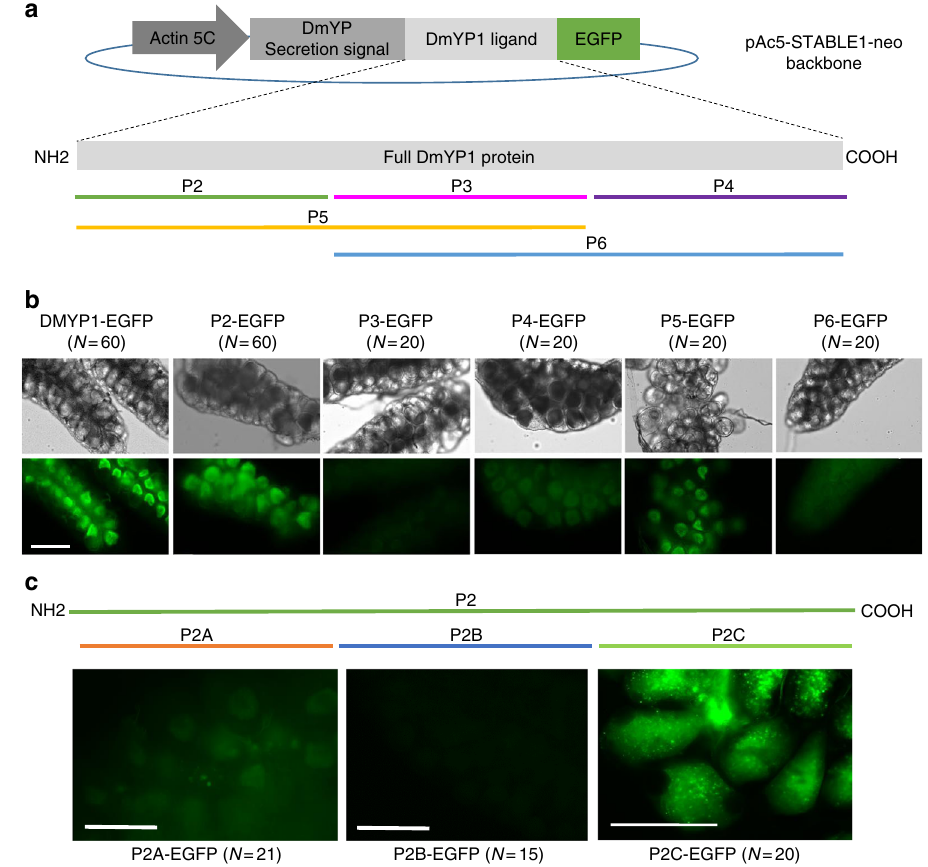
Fig. 1 Deletion mapping of D. melanogaster DmYP1 and P2C-mediated delivery of EGFP. a Schematic showing the construct pAc5-STABLE1-neo backbone modi fi ed to express and secrete EGFP fused to DmYP1 or any of its derivatives (P2, P3 – P4, P5, or P6) under the Actin5C promoter in S2 cells. Fragments P2, P3, and P4 are about 120 amino acids of DmYP1 each. Portion P5 contains portions P2 and P3. Portion P6 contains P3 and P4. b EGFP fusion proteins containing DmYP1 or each fragment (P2 – P6) as ligand were injected into the hemolymph of vitellogenic A. gambiae females. Ovaries were dissected 16 h after injections. Fragments containing the N-terminal region of DmYP1 showed the highest transduction of EGFP into the ovaries. c Deletion analysis of the P2 region. EGFP was detected at the highest intensity when fused to the P2C portion of DmYP1. Scale bar is 100 µ